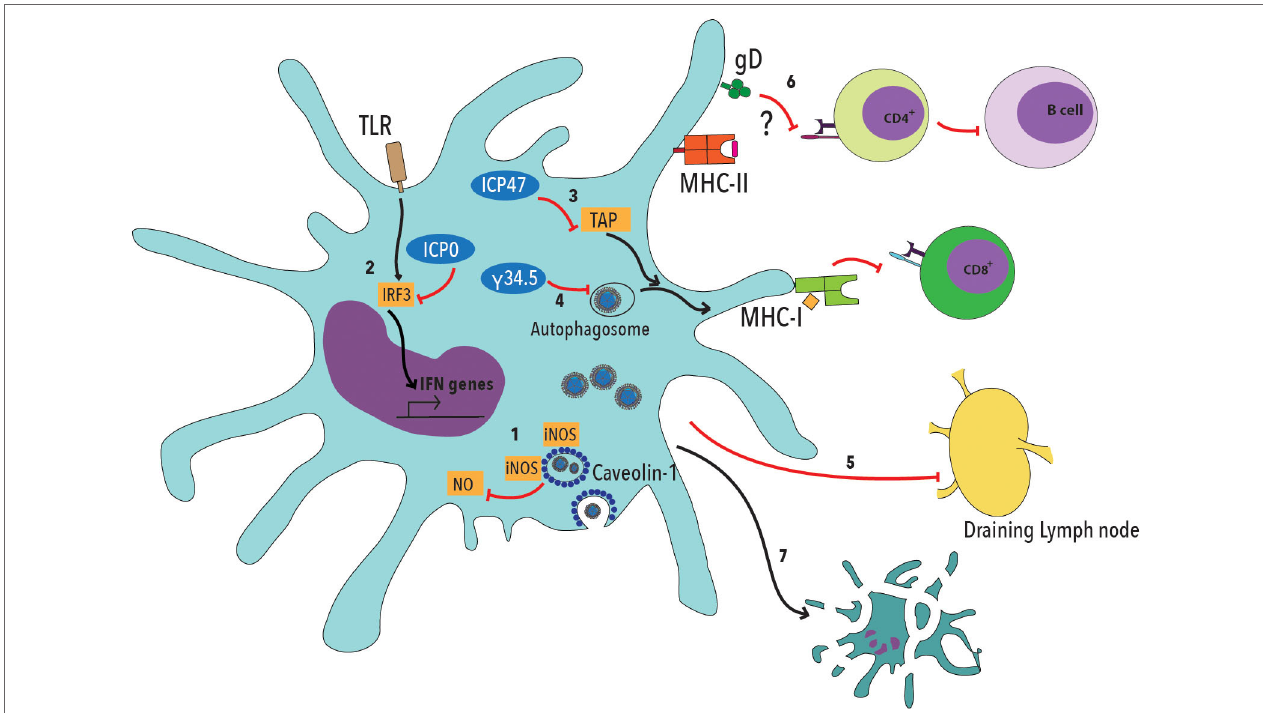
FiGUre 1 | Herpes simplex viruses negatively modulate dendritic cell function. 1. HSV viral proteins bind caveolin-1 and sequester inducible nitric oxide synthase (iNOS), dampening NO production within these cells, which has been described to be involved in cellular antiviral responses. 2. Viral ICP0 interferes with TLR-IRF3 signaling, thus reducing type-I interferon (IFN-I) production by DCs. 3. The HSV ICP47 viral protein interferes with peptide translocation from the cytoplasm to the endoplasmic reticulum, which is mediated by TAP (Transport Associated with Antigen Processing), thus decreasing antigen presentation to CD8 + T cells on MHC-I molecules. 4. HSV protein γ 34.5 blocks autophagosome maturation, thus reducing the capacity of DCs to process viral antigens. 5. DC infection with HSV interferes with the migration of these cells to the draining lymph nodes, where T cell activation takes place. 6. Glycoprotein D (gD) has been previously described to decrease T cell activation by negatively modulating TCR signaling. Such inhibition likely affects both, CD4 + and CD8 + T cells. 7. Finally, DC infection with HSV elicits